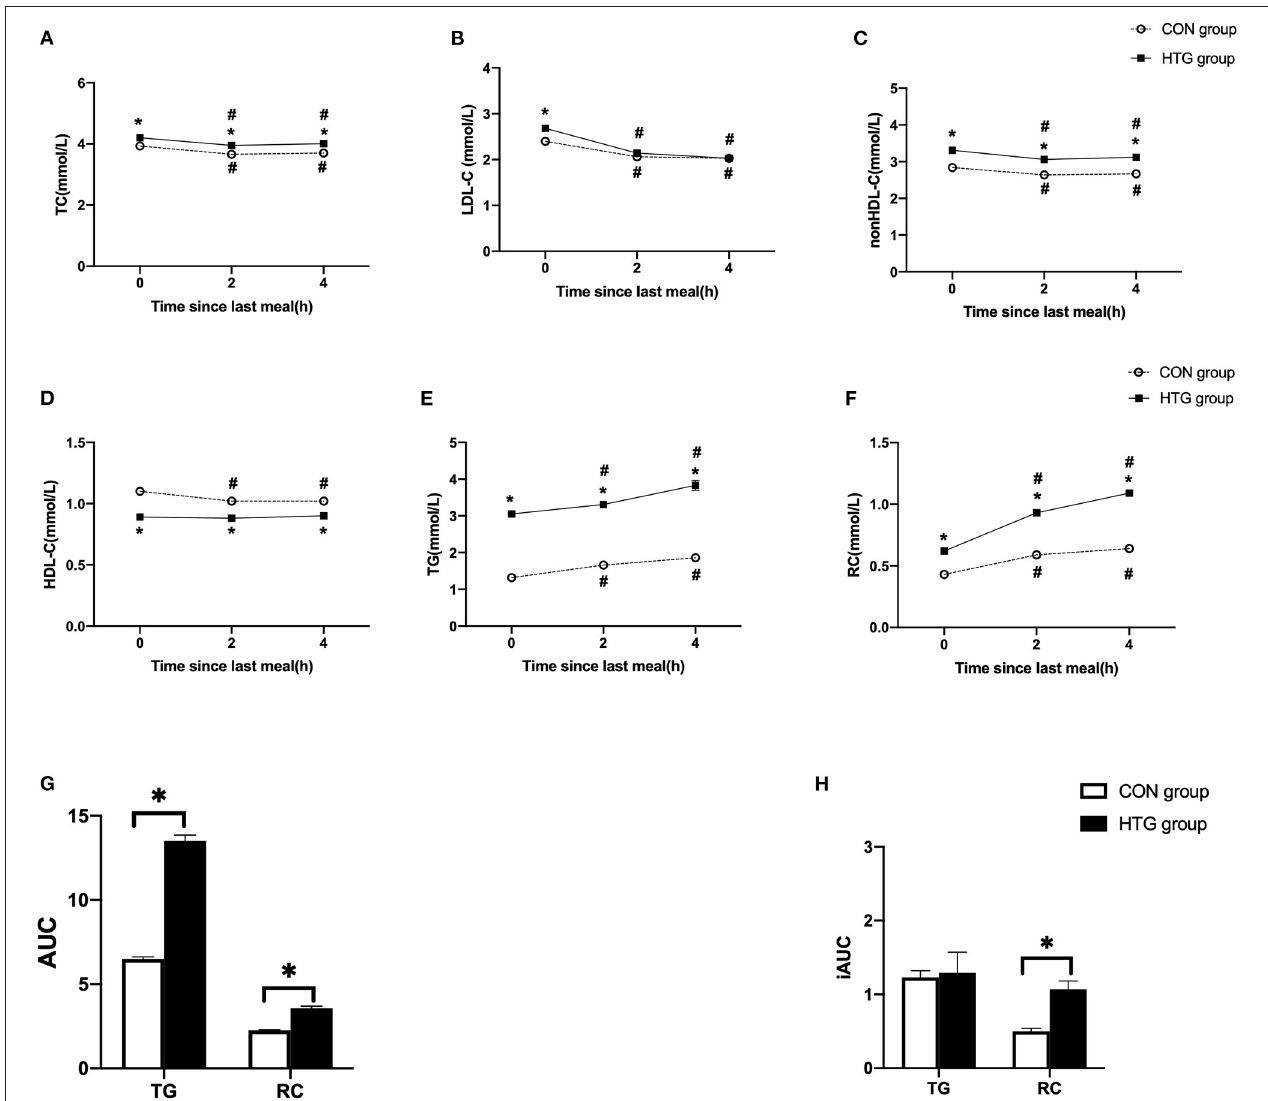
FIGURE 1 | Postprandial changes in blood lipids after a daily meal in two groups. (A,B,D,E) The changes in serum concentrations of total cholesterol (TC), low-density lipoprotein cholesterol (LDL-C), high-density lipoprotein cholesterol (HDL-C), and triglyceride (TG). (C,F) The changes in serum concentrations of non-HDL-C and remnant cholesterol (RC) determined by calculated methods. (G) Comparison of total area under the curve (AUC) for TG and RC between two groups. (H) Comparison of increase in AUC (iAUC) for TG and RC between two groups. Hypertriglyceridemia (HTG) group: fasting TG ≥ 2.3 mmol/L. CON group: fasting TG < 2.3 mmol/L. Values are mean ± standard error (SE). One-way analysis of variance (ANOVA) for repeated measures within a group or ANOVA for completely randomized measures between groups was used to assess any differences between the means of the variables, as appropriate. # p < 0.05 when compared with the fasting level in the same group. * p < 0.05 when compared with the patients in the CON group.